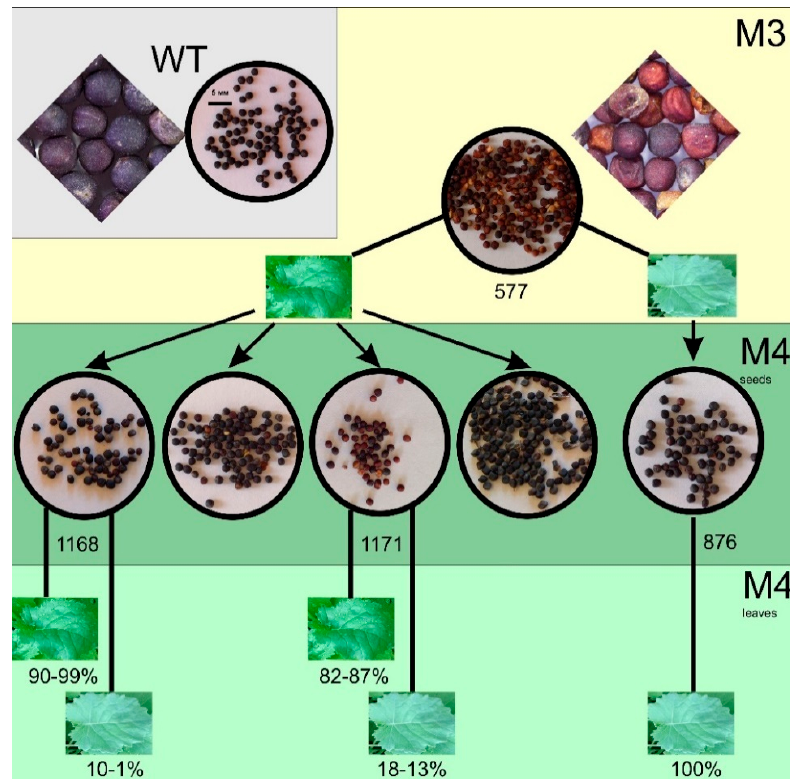
Figure 2. The pattern of the segregation of mutant lines of spring rapeseed (M 3 –M 5 ), differing in the presence/absence of glaucous bloom. Mutant lines are designated as “glossy”. Segregation was absent in the progeny of glaucous plants.